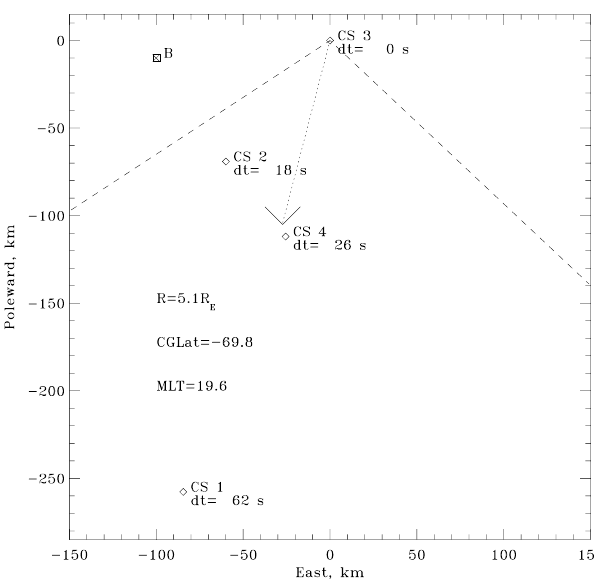
Fig. 1. 19 May 2002. The direction of motion (dotted line) and configuration of the s/c in a plane perpendicular to the background magnetic field. dt is the time separation of the satellites passing through this plane, with respect to s/c 3. The orientations of the current sheets (see the text) are shown as dashed